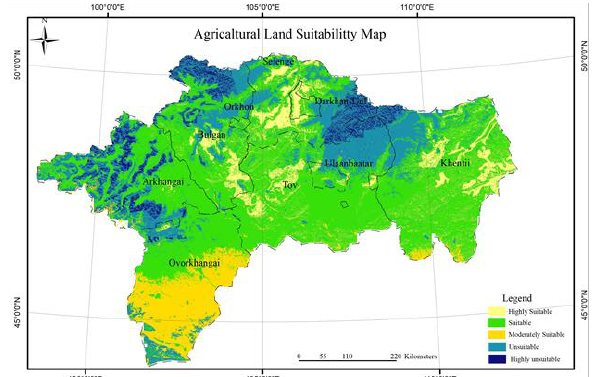
Figure 7. Obtained spatial distribution of suitable cropland in the central agricultural region of